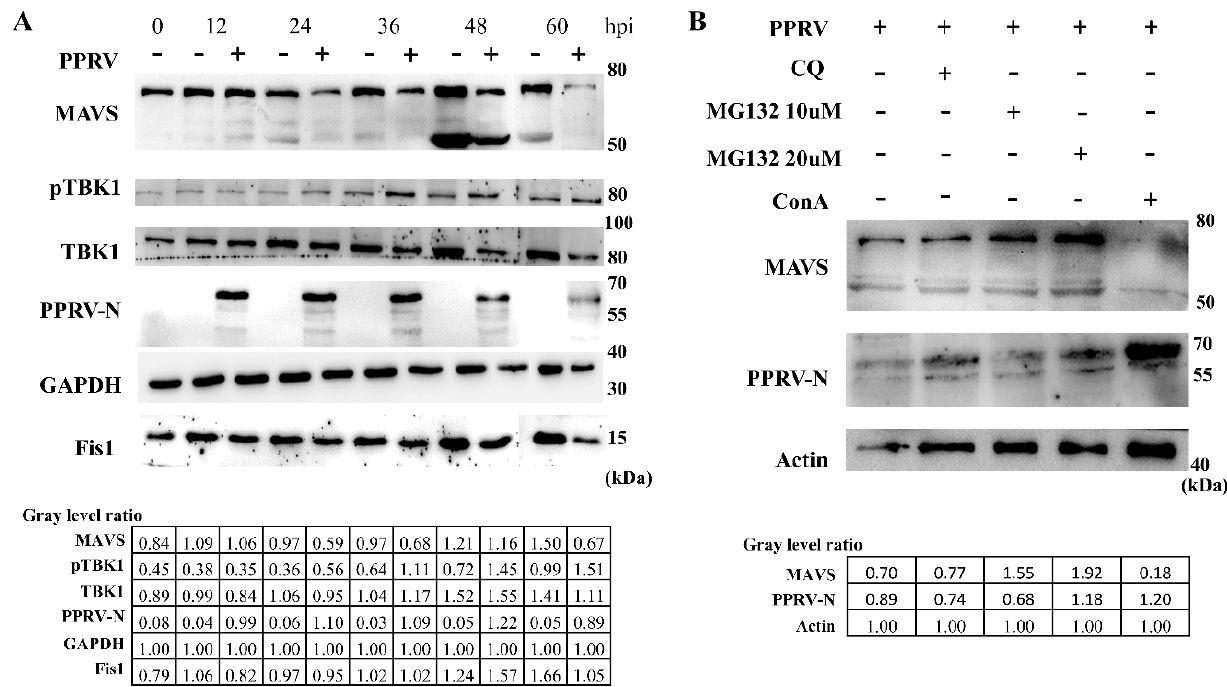
Figure 7. caMAVS is degraded through the proteasome pathway during PPRV infection. ( A ) EECs were infected with the PPRV vaccine strain, Nigeria/75/1, at MOI 10. The relative protein level of several important molecules during viral infection was checked by WB. ( B ) Several inhibitors were used after infection of PPRV on EECs to demonstrate which pathway is involved in MAVS degradation. The relative level of individual proteins was quantified with respect to β-actin.